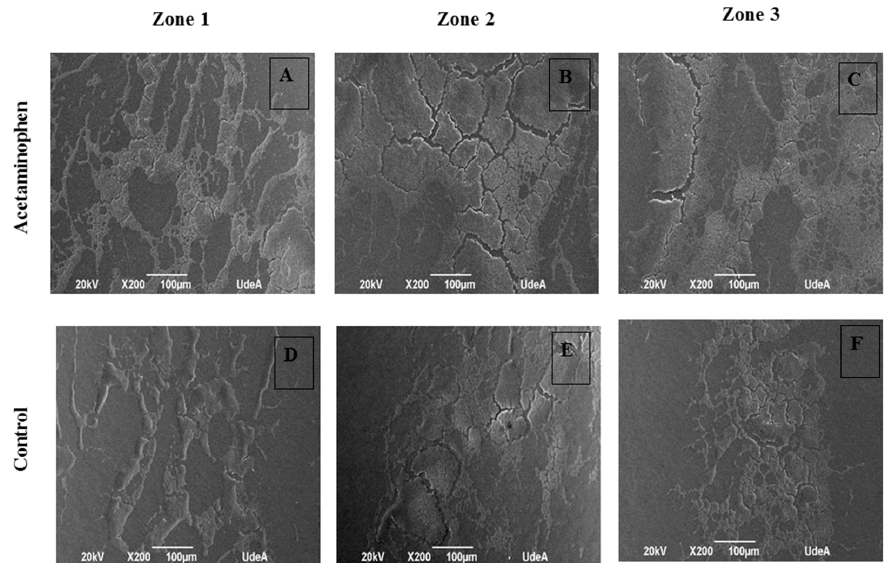
Figure 7. Scanning electron microscope Image of K. pneumoniae ATCC 13884 biofilm assembled on urethral catheter. ( A – C ) Biofilm formed under the effects of acetaminophen displayed large colonization areas and compact masses bacteria in prominent islets. ( D – F ) Biofilm without treatment showed more empty zones with free bacterial masses. Bar 100 µm.